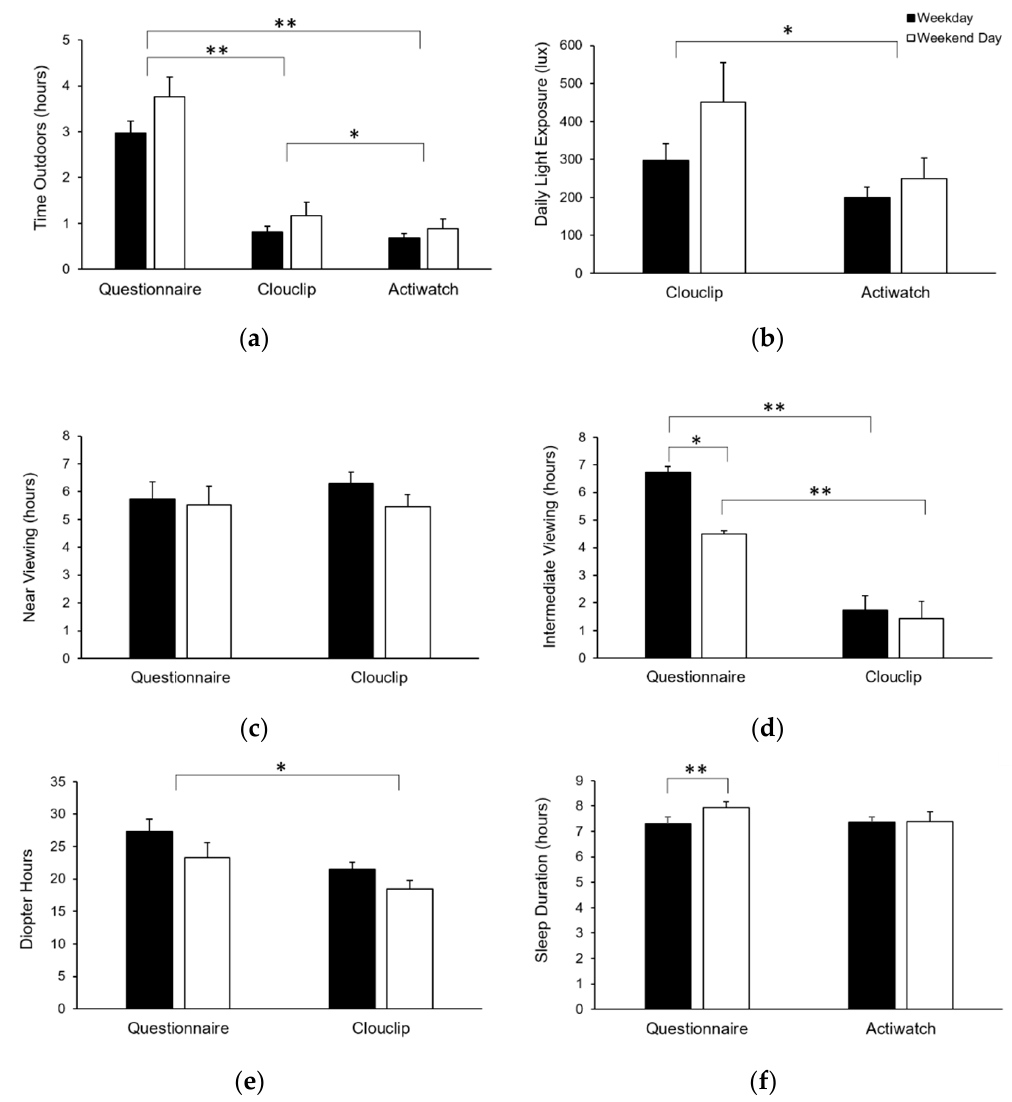
Figure 2. ( a ) Time outdoors (hours), ( b ) daily light exposure (lux), ( c ) near viewing (hours), ( d ) intermediate viewing (hours), ( e ) diopter hours, and ( f ) sleep duration on weekdays (filled bars) and weekend days (open bars) derived from the questionnaire, Clouclip, and Actiwatch; asterisks (*) represent statistically significant differences determined by repeated measures ANOVAs, * p < 0.05, ** p < 0.001.